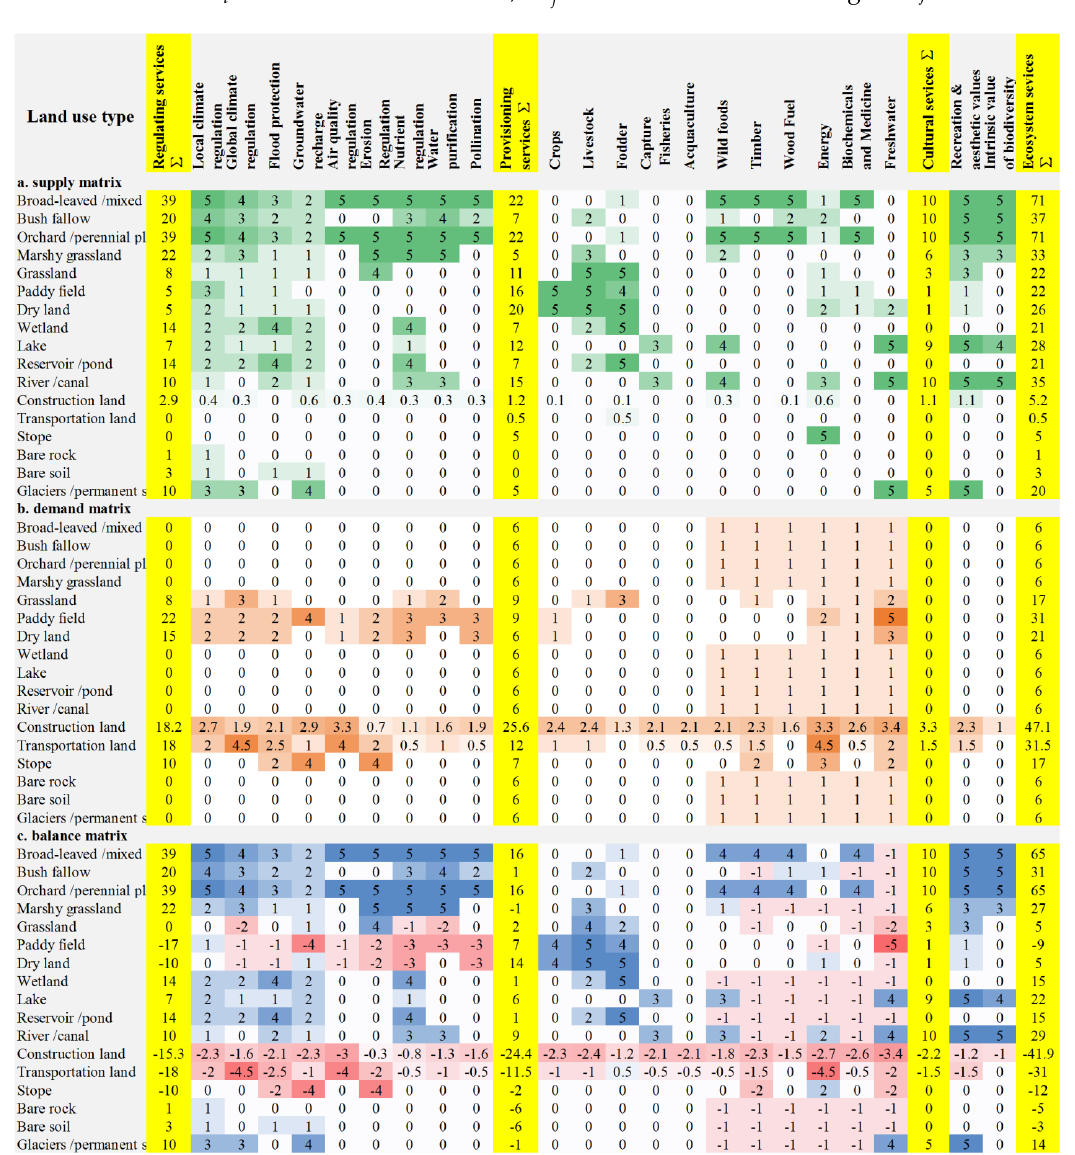
Figure 2. Assessment matrix of ES supply and demand for different land use types.